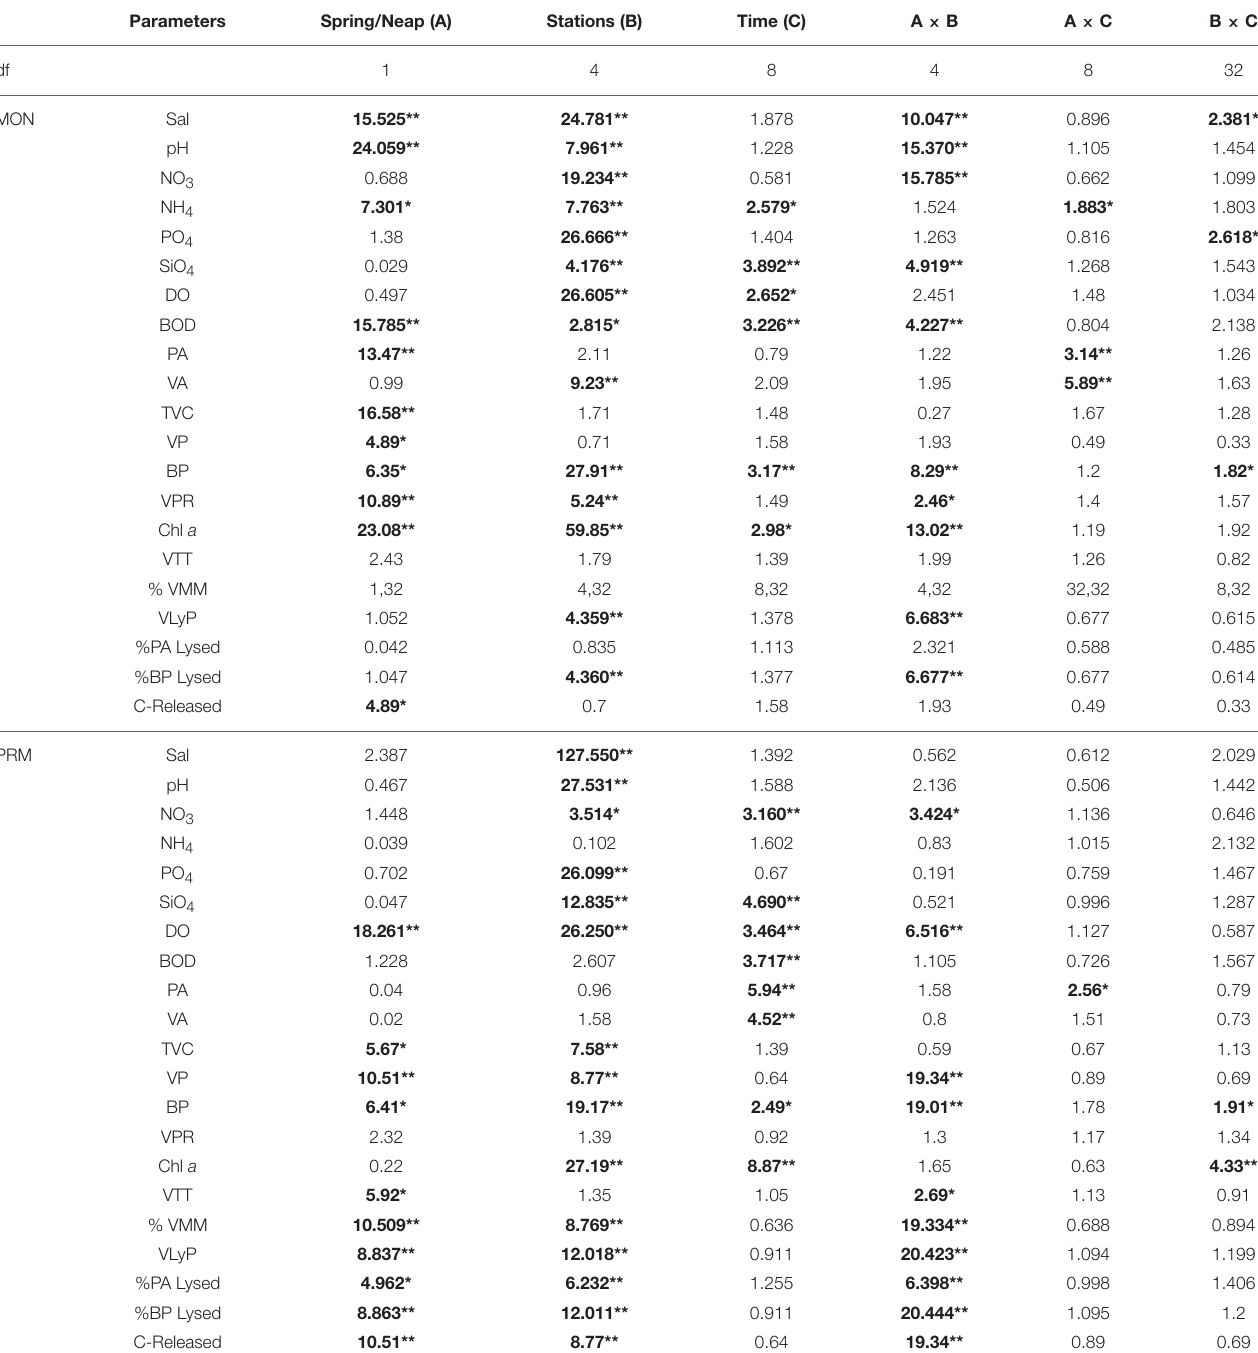
TABLE 1 | Table showing results of the 3 WAY ANOVA for comparing spring and neap observations between different stations and between different time points.